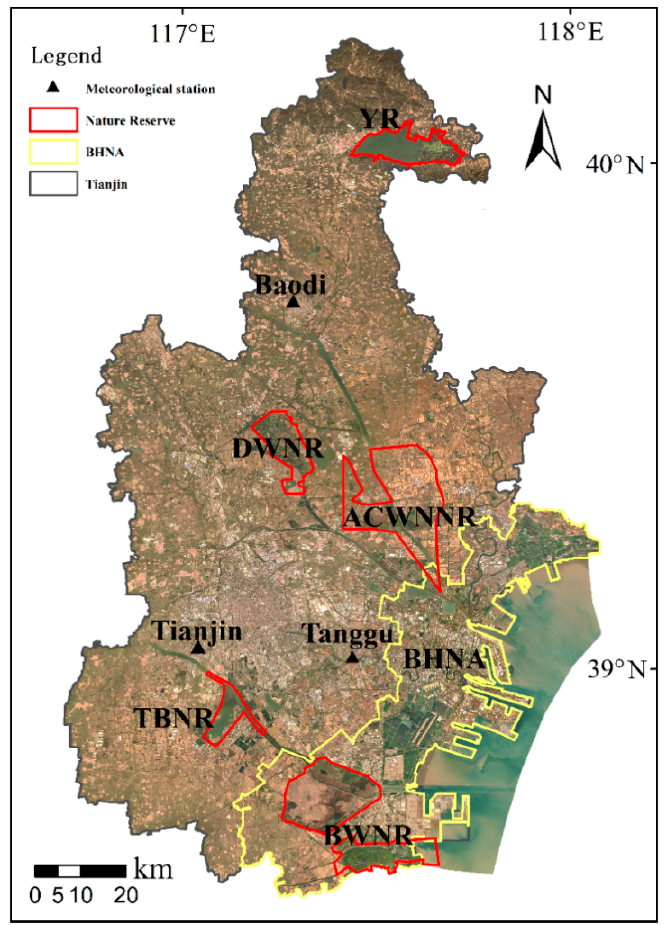
Figure 1. The location of study area. The true-color image is the Landsat-8 OLI image collected on 12 September 2017 and 26 October 2018. The boundaries of the four nature reserves (Beidagang Wetland Nature Reserve (BWNR), Dahuangpu Wetland Nature Reserve (DWNR), Ancient Coast and Wetland National Nature Reserve (ACWNNR), Tuanbo Birds Nature Reserve (TBNR)), Binhai New Area (BHNA) and Yuqiao Reservoir (YR) of Tianjin are delineated with red lines and yellow lines. Note that the two red boundaries near BWNR all belong to BWNR.